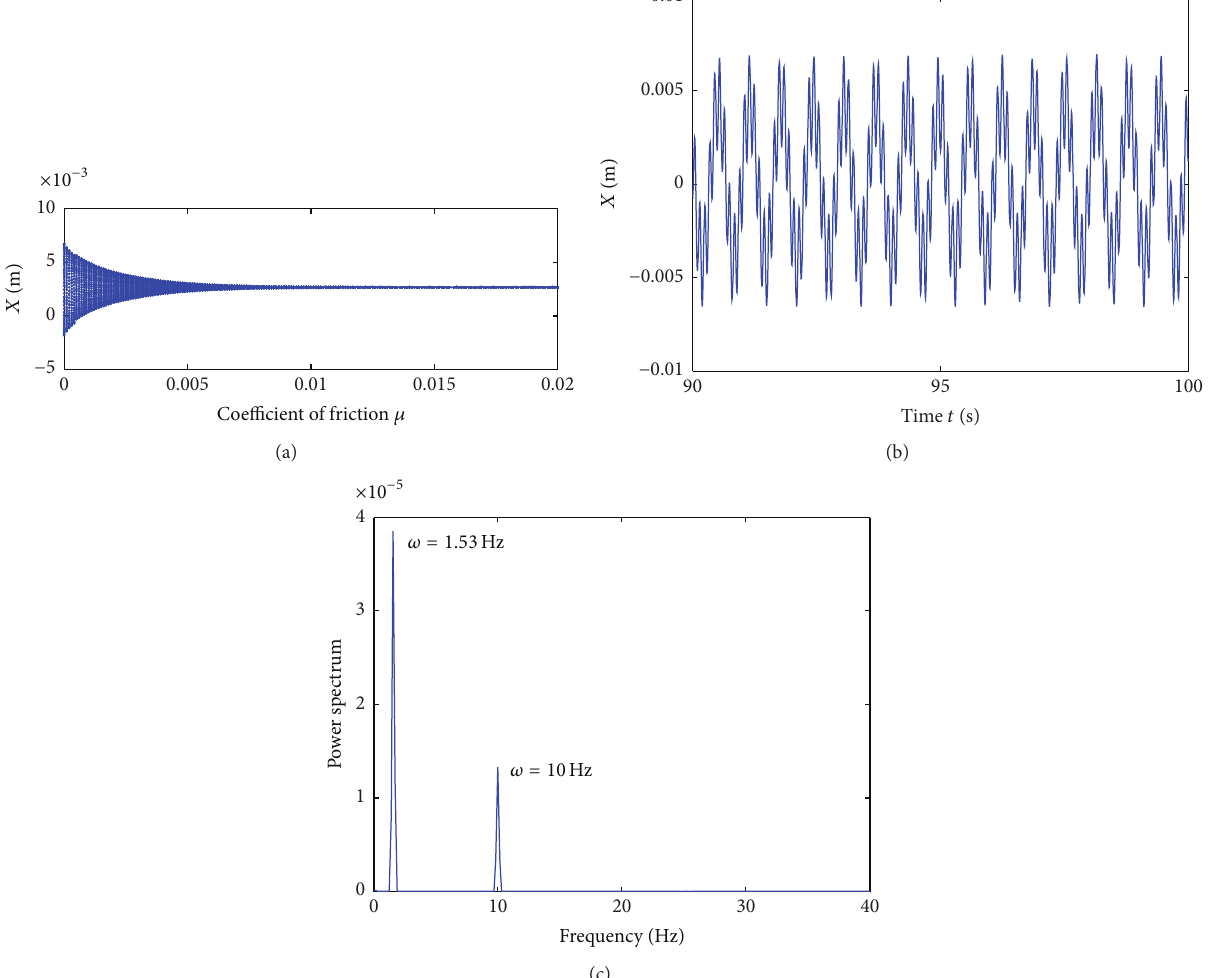
Figure 6: Bifurcation diagram of the system as 𝜇 varies (a); 𝑋 displacement when 𝜇 = 0 (b); Power spectrum